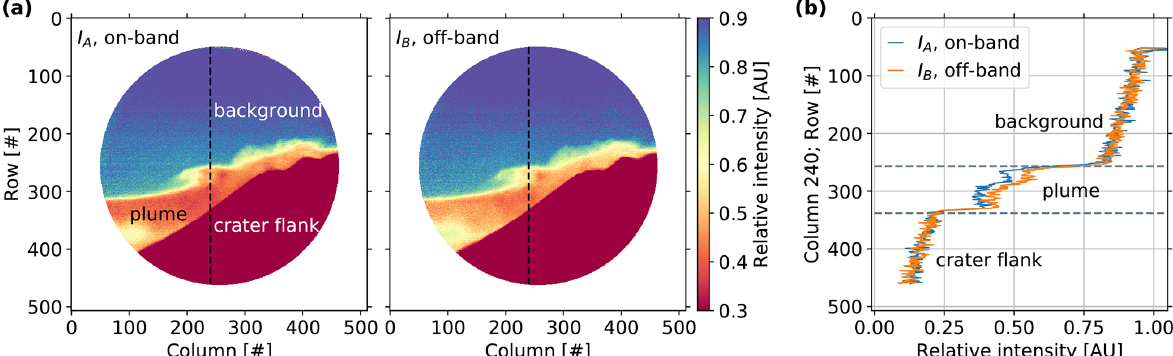
Figure 6. (a) Flat-field-corrected intensity images (400 × 400 pixels) acquired with the IFPICS prototype in on-band I A and off-band setting I B . The I A image shows the expected higher SO 2 absorption in comparison with I B ( I A < I B in plume region). The plume is visible in both images due to the broadband SO 2 absorption and other extinction in the measurement spectral range. The circular image shape arise from the FPI’s circular clear aperture. (b) Intensity column 240 (dashed black lines in a ) for I A (blue) and I B (orange). The enhanced absorption (reduced intensity) is clearly visible in the plume section with I A < I B , whereas in the background sky and crater flank sections, the intensities are equal: I A = I B